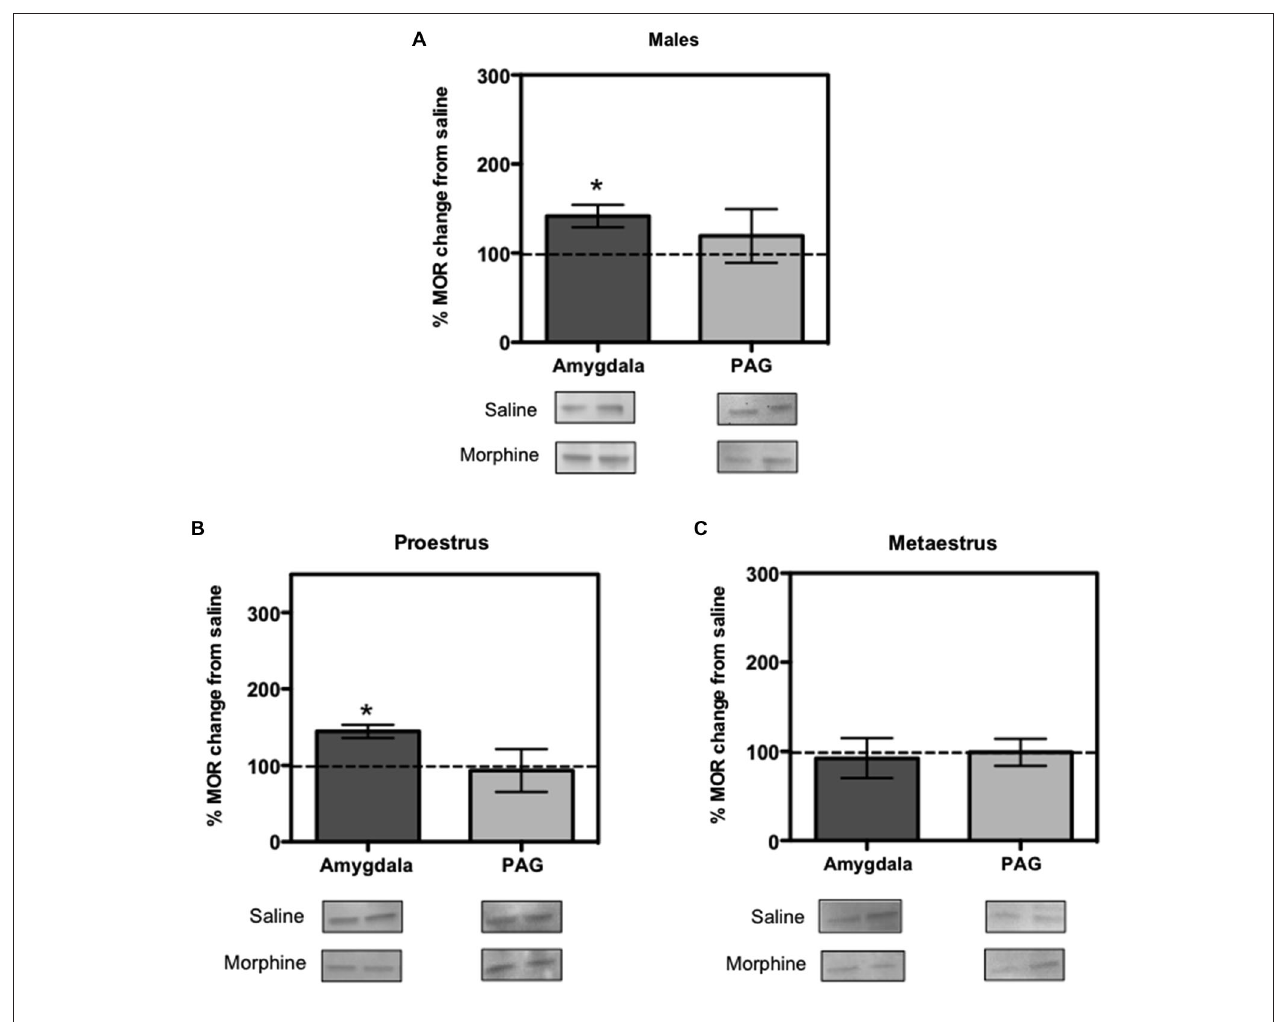
female the amygdala showed an increase in MOR expression produced by morphine ( p < 0.05). (C) In metaestrus female rats the amygdala and periaqueductal gray (PAG) showed no significant difference in MORs expression compared to